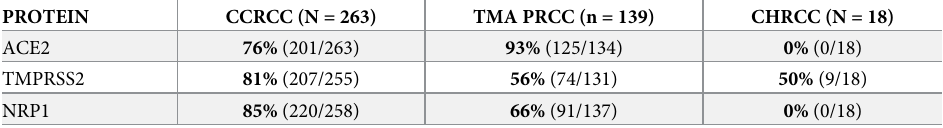
Table 1. Assessment of protein expression of ACE2, TMPRSS2 and NRP1 in clear cell, papillary and chromo- phobe renal cell carcinoma. PROTEIN CCRCC (N = 263) TMA PRCC (n = 139) CHRCC (N = 18) ACE2 76% (201/263) 93% (125/134) 0% (0/18) TMPRSS2 81% (207/255) 56% (74/131) 50% (9/18) NRP1 85% (220/258) 66% (91/137) 0% (0/18) TMA, tissue microarray; CCRCC, clear cell renal cell carcinoma; PRCC, papillary renal cell carcinoma; CHRCC, chromophobe renal cell carcinoma. Due to random drop out of TMA-cores the number of assessed cores may vary slightly.